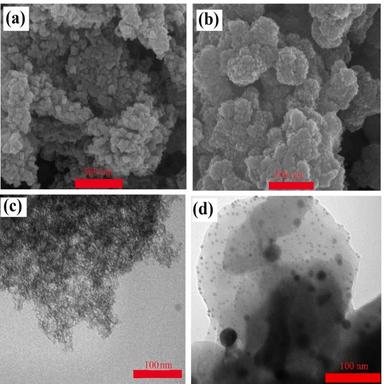
SEM image of DMC (a) and DMC/MnO2 (b); TEM image of DMC (c) and DMC/MnO2 (d).